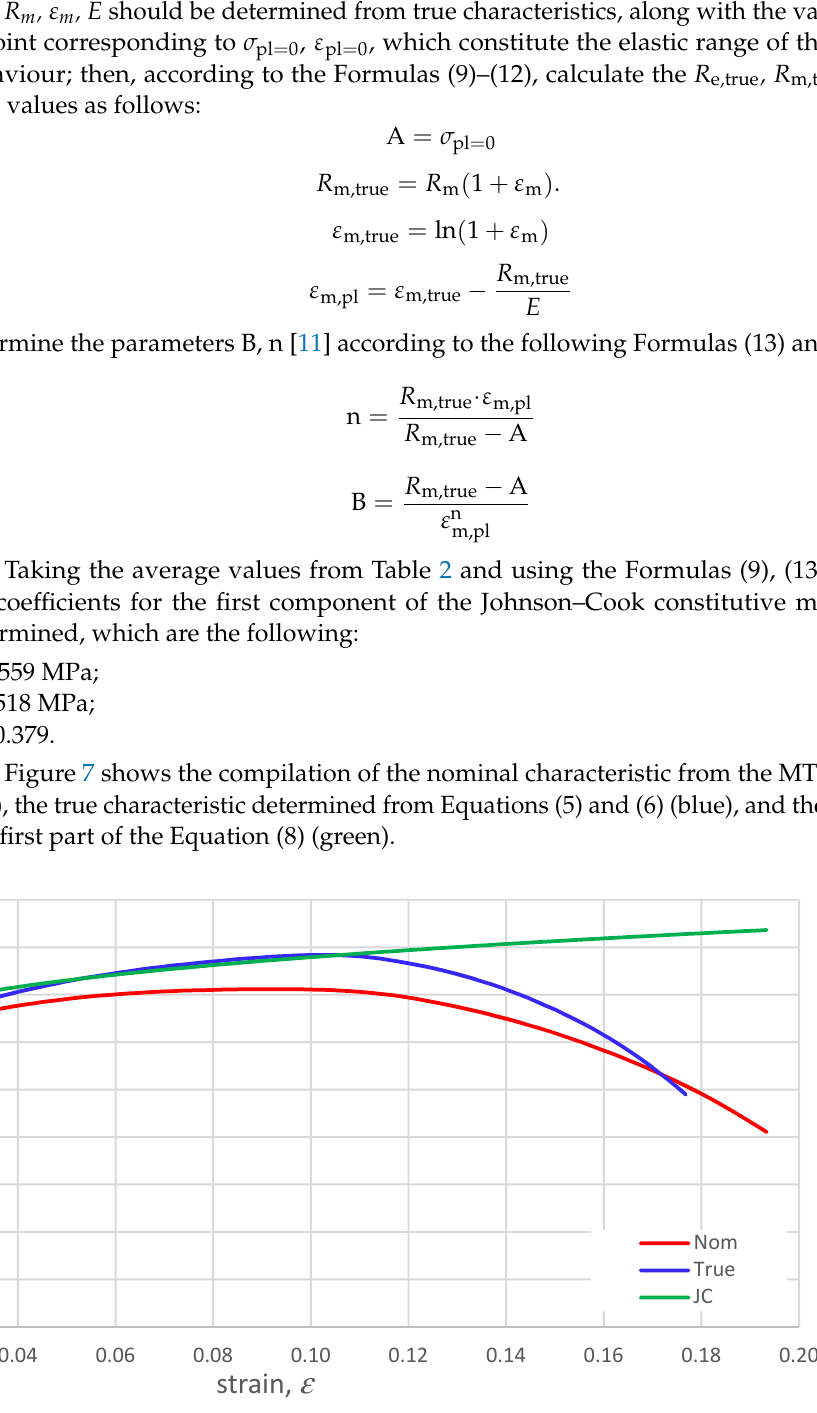
Figure 7. Comparison of the nominal, true characteristics and the proposed Johnson Cook HY 80 steel model, strain rate . ε = 0.0001 s − 1